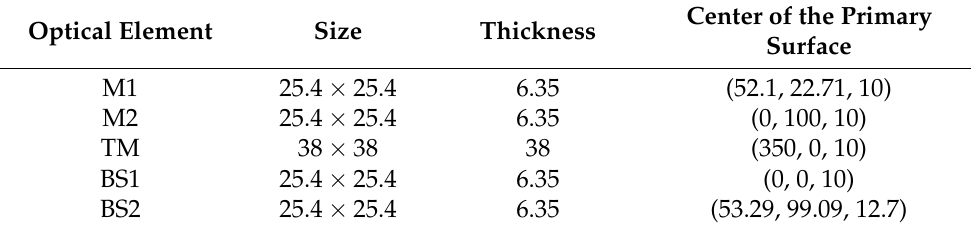
Figure 6. The final interferometer layout after optimization for the setup with lenses after BS2 ( left ) and before BS2 ( right ). The reference beam is highlighted green for sake of comparison. The measurement beam is shown in red and it is illustrated for the case, where the test-mass (TM) is rotated by 5 mrad. The arm length difference between the green and the red path is 571.833 mm. The unit is given in (mm). Table 1. Optical Elements. All units in (mm).